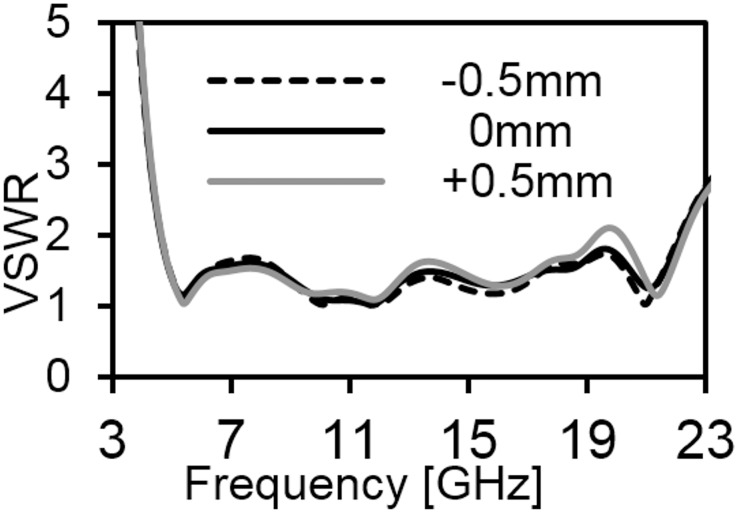
Effects on VSWR with changing rarc parameter.